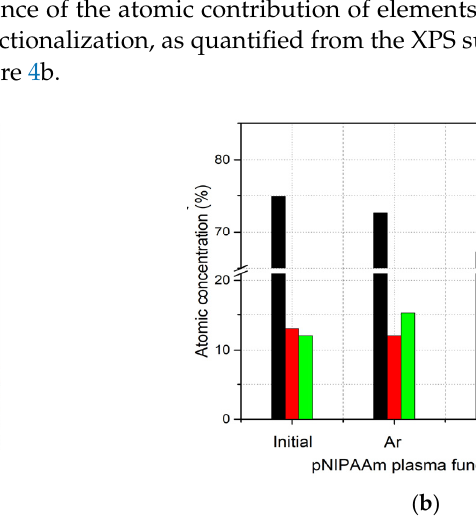
Figure 4. Survey spectra for initial and plasma-treated pNIPAAM coatings ( a ); variation of the atomic concentration of the main elements regarding the gas plasma treatment ( b ).